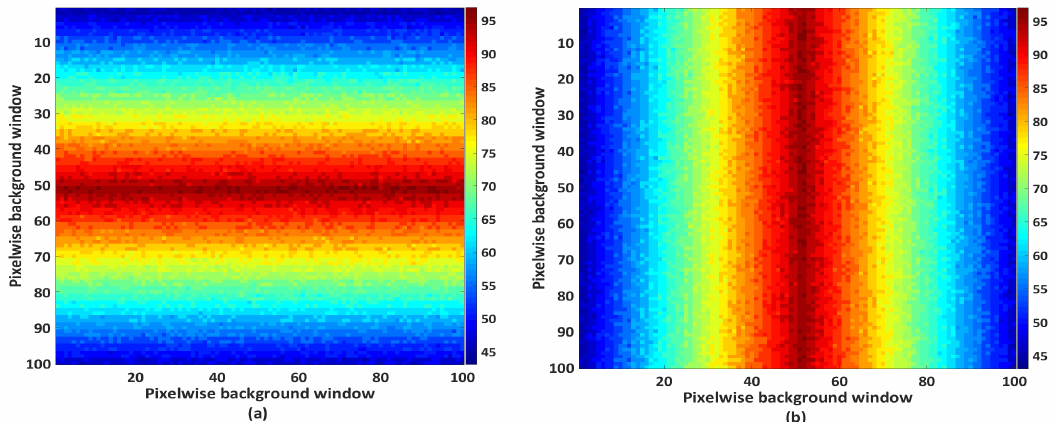
Figure 15. Pixelwise perturbation to spatial variability of the background window with no rotation ( a ) and 90 ◦ rotation ( b ).